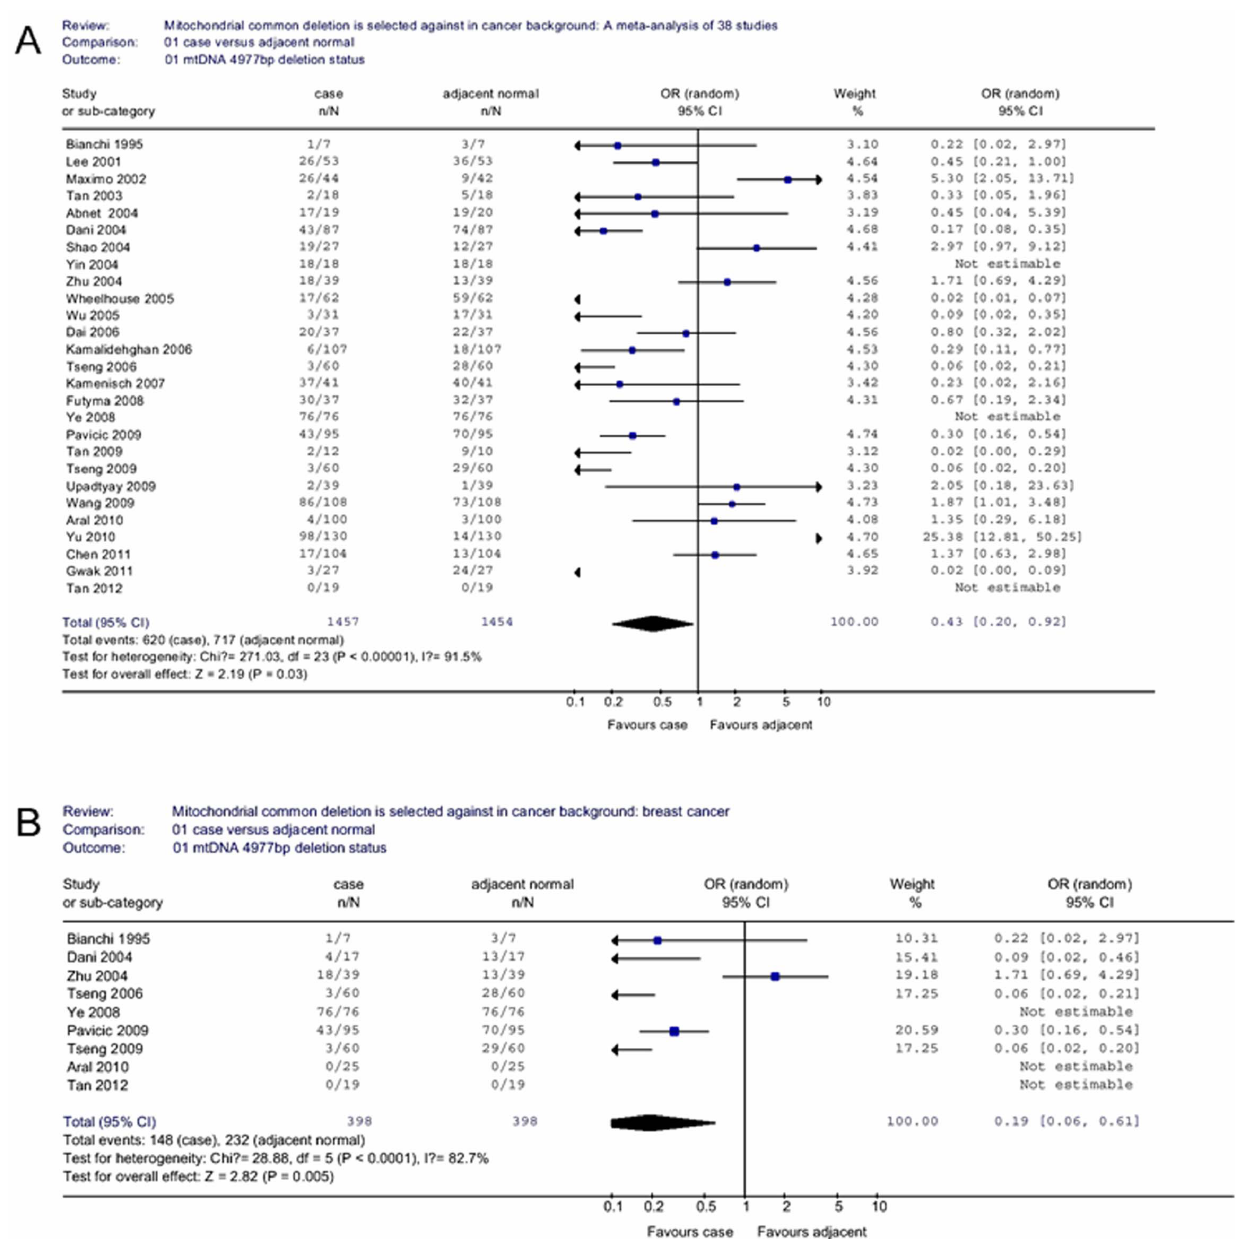
Figure 1. Odds ratios (ORs) and 95% confidence intervals (CIs). (A) various cancer types associated with mtDNA 4977 bp deletion in case/ adjacent normal group. (B) stratified analysis for breast cancer associated with mtDNA 4977 bp deletion in case/adjacent normal group.